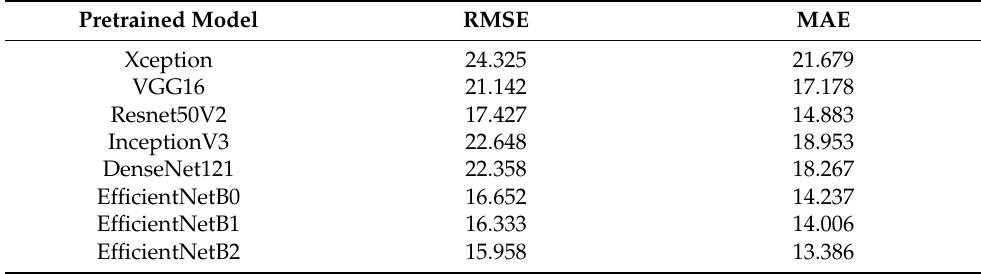
Table 1. Result of training different pretrained